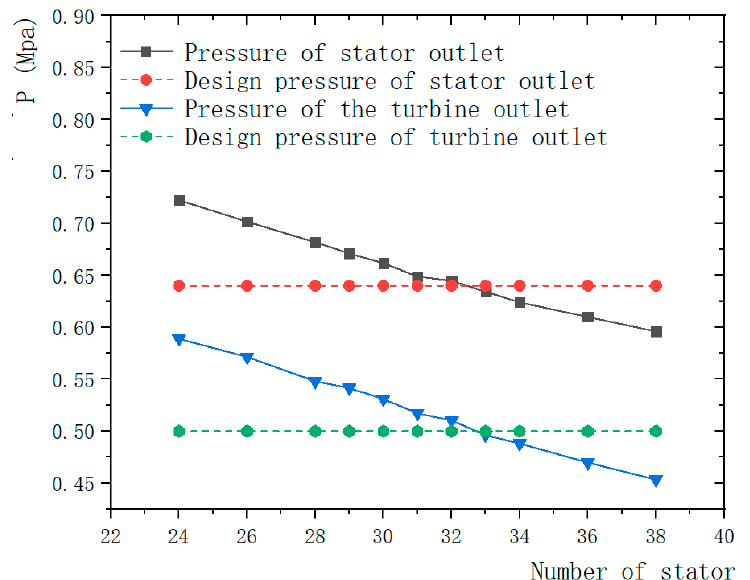
Figure 10. Comparison of design value and simulation value of turbine inlet and outlet pressure and stator outlet pressure at different number of stator blades.